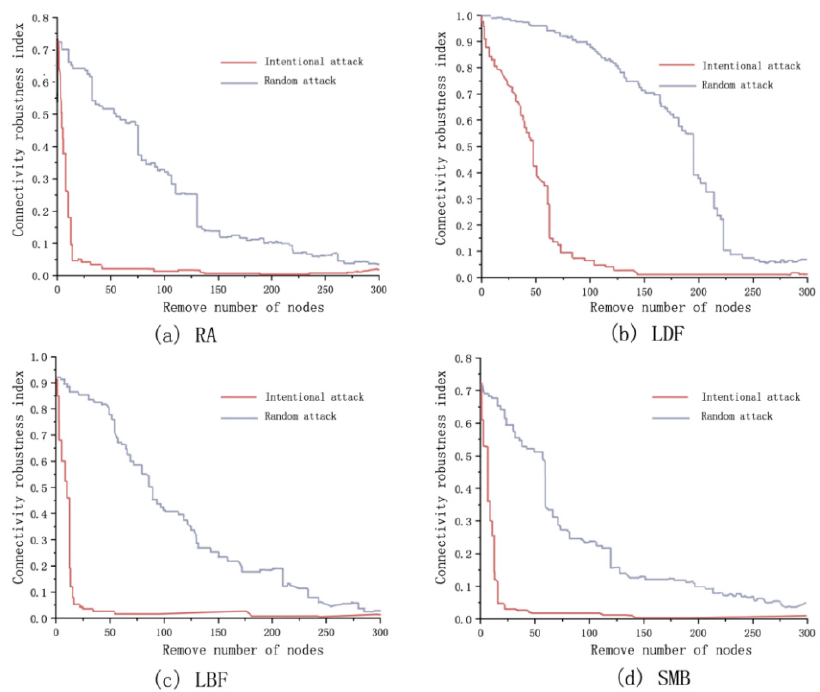
Figure 8. Connection robustness analysis of ecological network with different optimization strategies: ( a ) connection robustness analysis of ecological network under RA; ( b ) connection robustness analysis of ecological network under LDF; ( c ) connection robustness analysis of ecological network under LBF; ( d ) connection robustness analysis of ecological network under SMB.